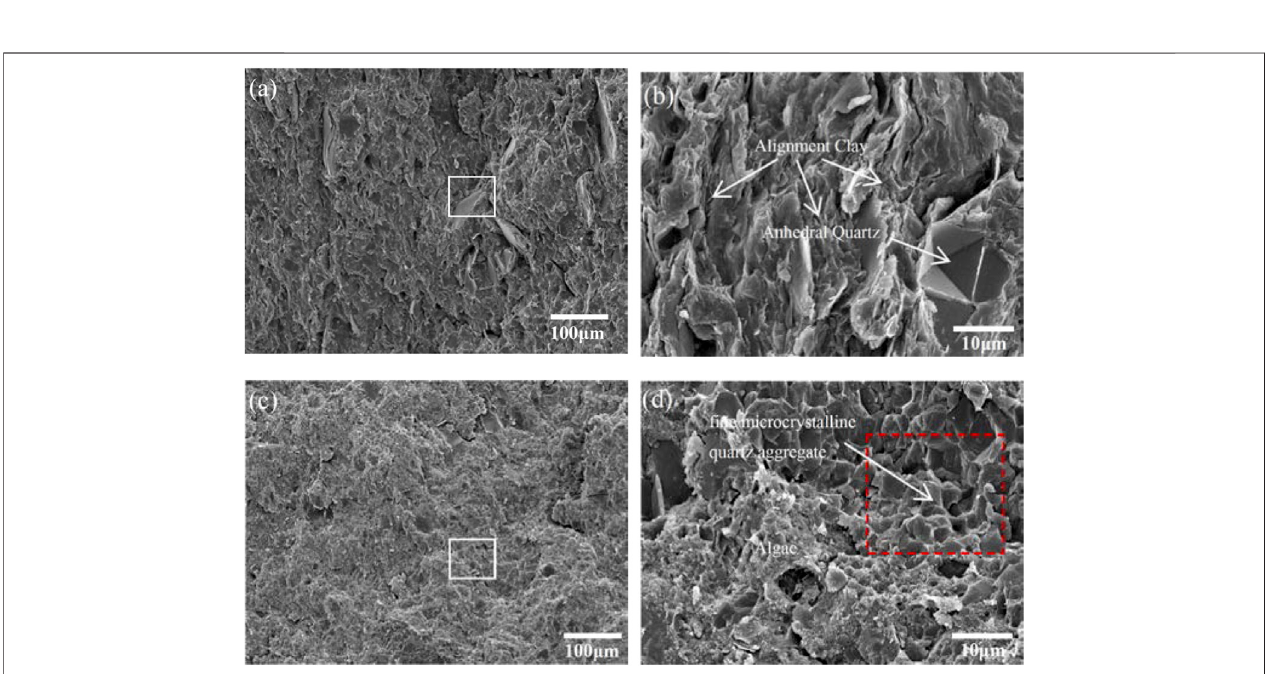
FIGURE 5 | Examples of microtextures observed on SEM. White rectangles are the magni fi cation areas. (A) and (B) Very coarse microcrystalline quartz with surrounded alignmentclay(Sample C7;TOC: 1.65%; Porosity: 1.8%; shallowwatershelf). (C) and (D) Compact fi nemicrocrystalline quartz (Sample C51; TOC:5.68%; Porosity: 4.2%; deep water